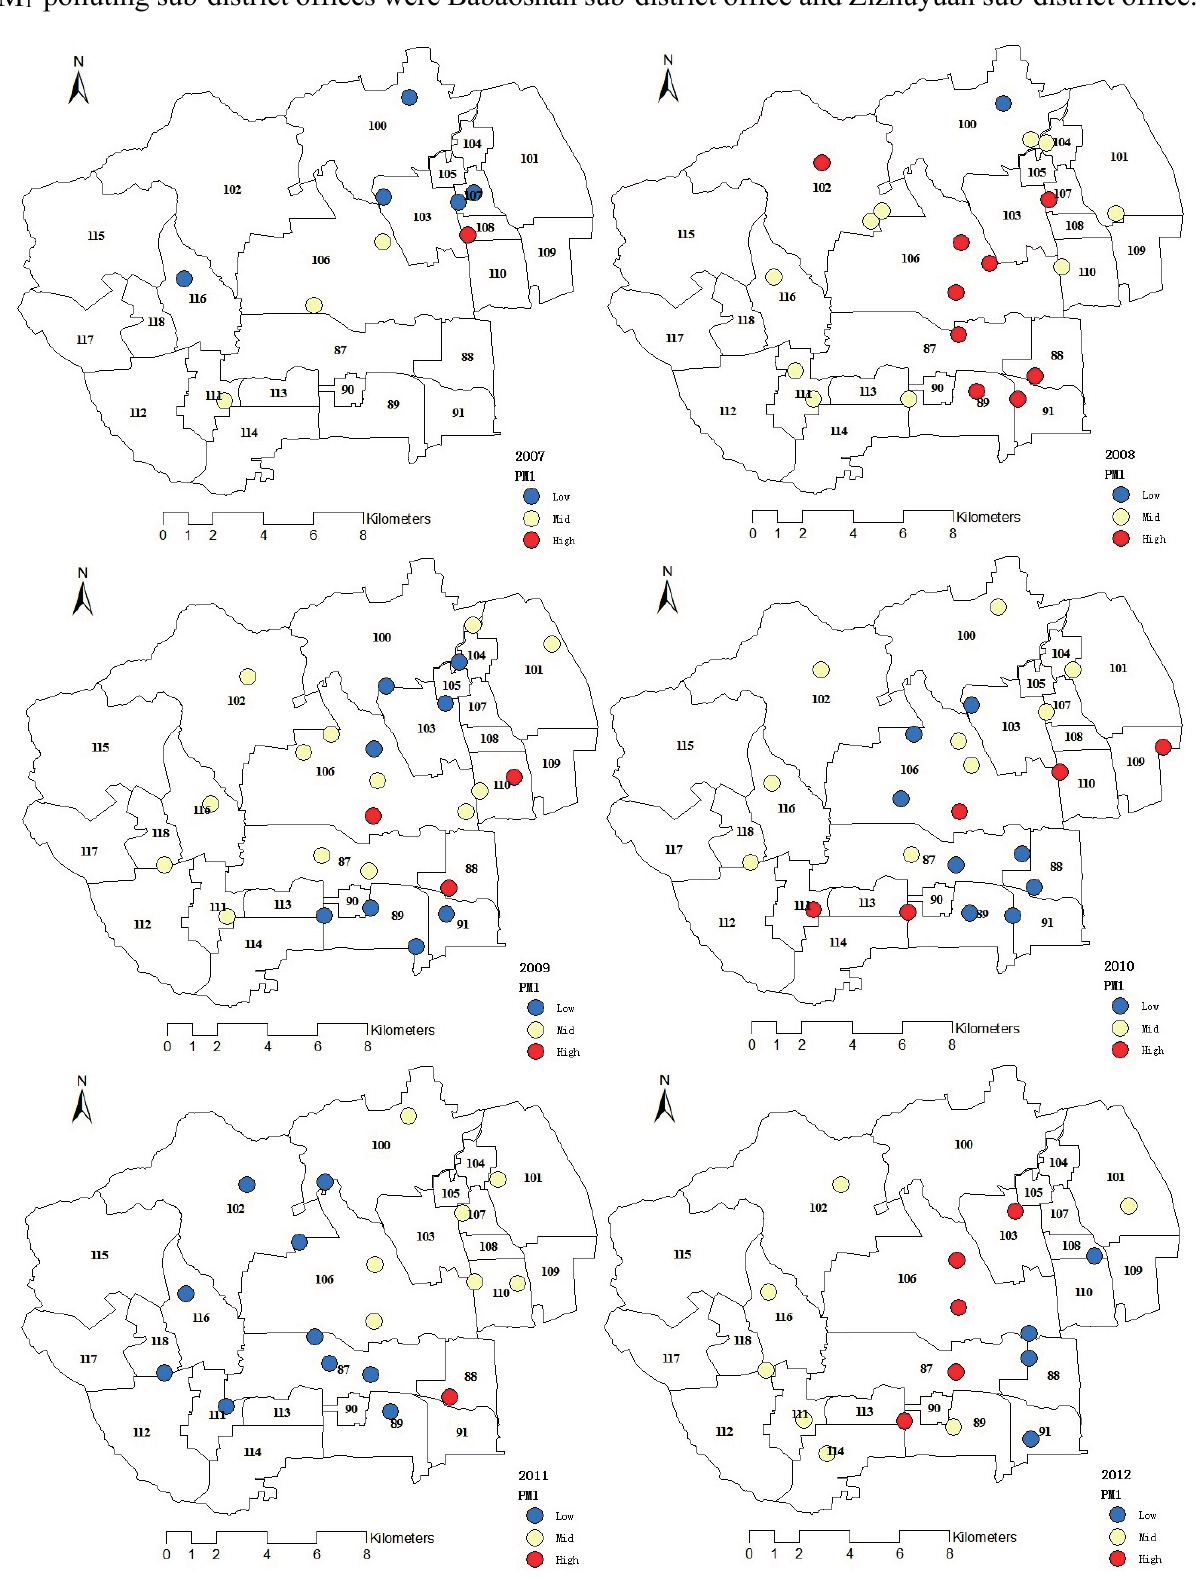
Figure 2. Spatial distribution of PM 1 from 2007 to